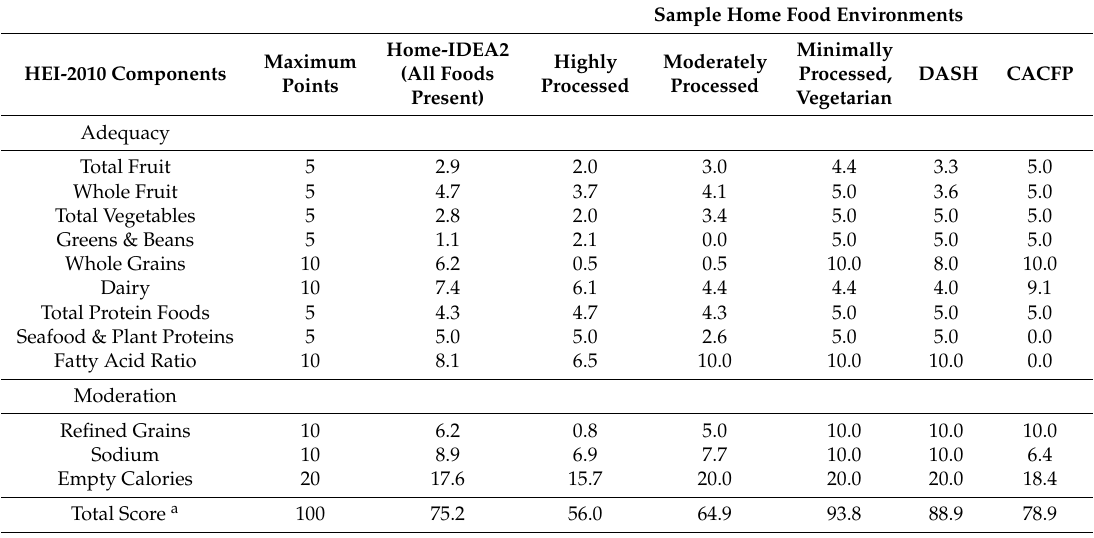
Table 5. Construct validity: five sample home food environments and resulting HEI-2010 component and total